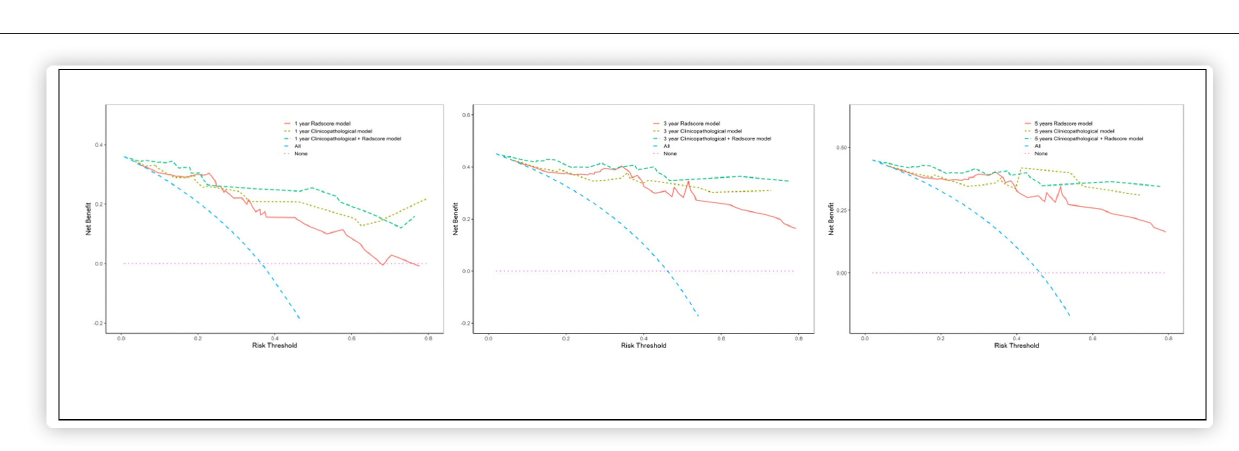
FIGURE 5 | Decision curve analysis for each model between the observed 1-, 3-, and 5-year